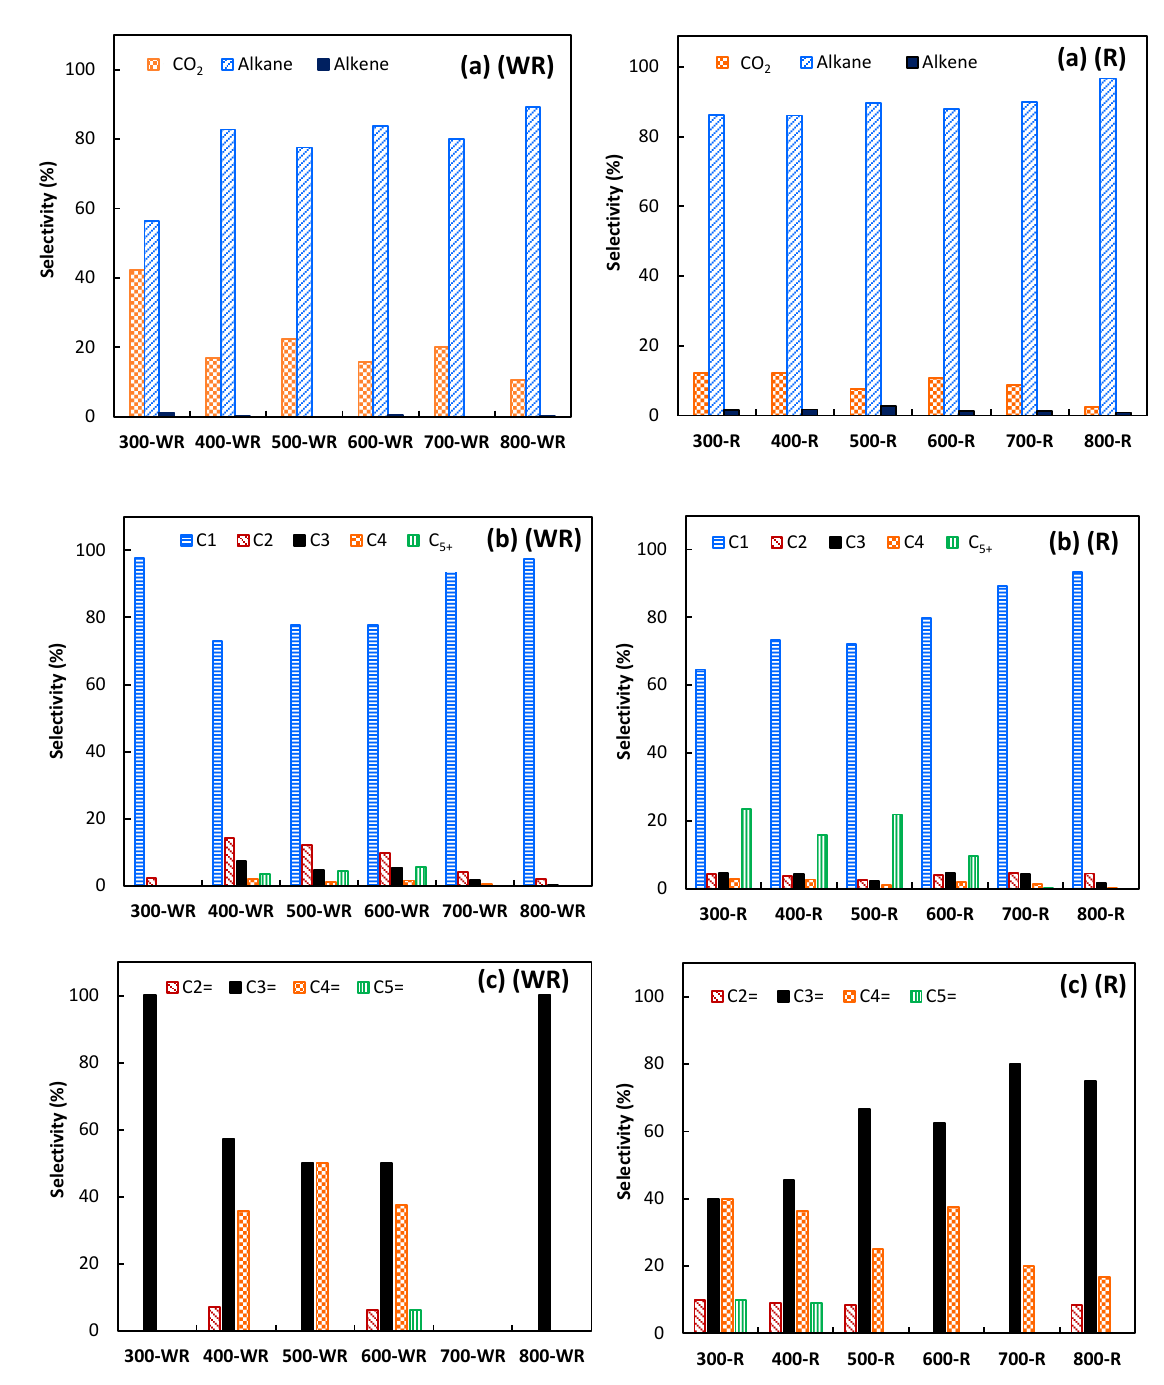
Figure 6. Gaseous product distribution in the FT reaction carbide catalysts: ( a ) hydrocarbon distri- bution, ( b ) alkanes distribution, and ( c ) alkenes distribution (WR: without reduction step, R: with reduction step).